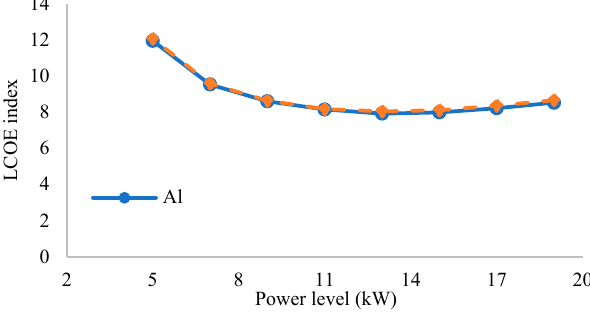
Figure 22. LCOE index copper vs. aluminum (Tehran).